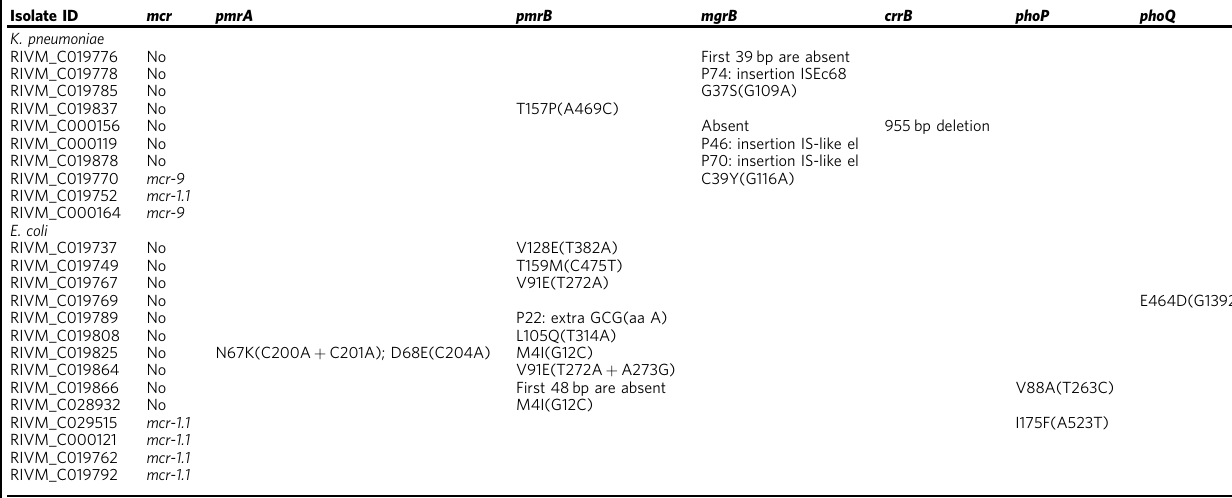
Point mutations are indicated by the amino acid substitution (nucleotide substitution) with the number representing the location. Silent mutations and mutations that were present in (both colistin- resistant and) colistin-susceptible isolates were not included in this table. aa amino acid, bp base pairs, el element, MIC minimum inhibitory concentration, p